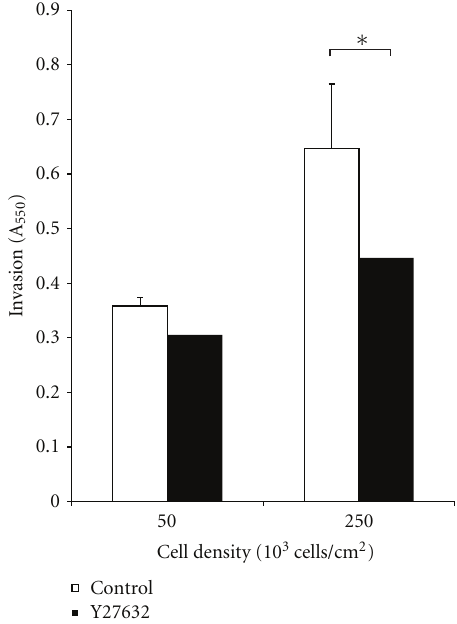
Figure 3: SW620 cells were seeded at densities of 50 × 10 3 and 250 × 10 3 cells/cm 2 onto Boyden chambers with an 8 μ m pore membrane. The wells were treated with Y-27632 to study the impact of ROCK inhibition on cell invasion in a low- and high-density environment. A 3.5-fold increase in cell invasion was observed in Y-27632-treated cells seeded at a lower density of 50 × 10 3 cells/cm 2 .